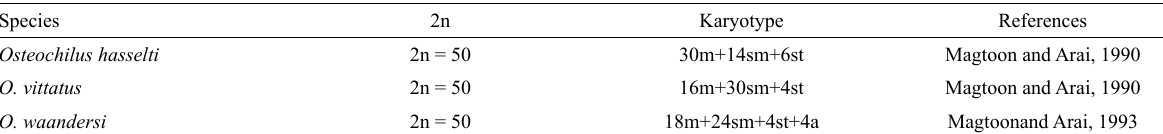
Table 1 – Available cytogenetic data for Osteochilus species. Species